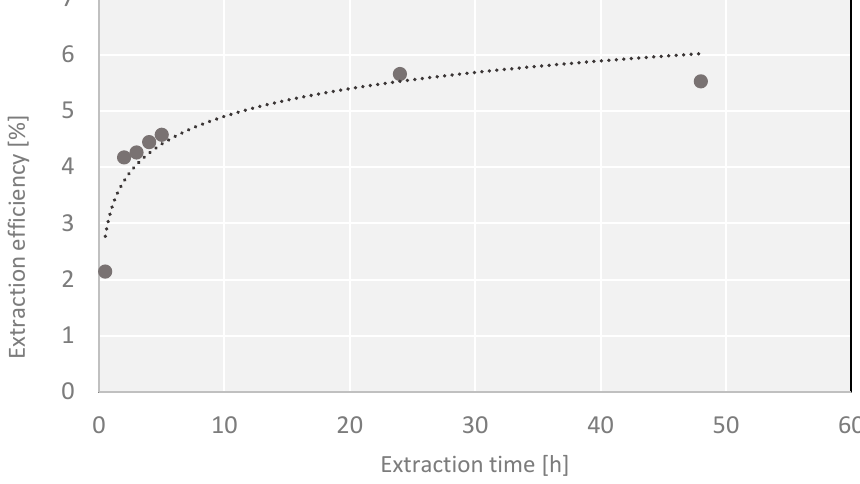
Figure 2. Dependence of the yield on the extraction time in a Knöfler-Böhm apparatus.